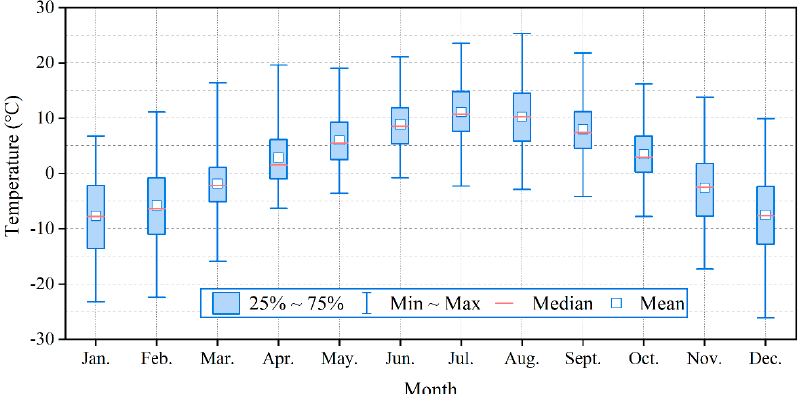
Figure 3. The annual dry-bulb temperature of Aba County.